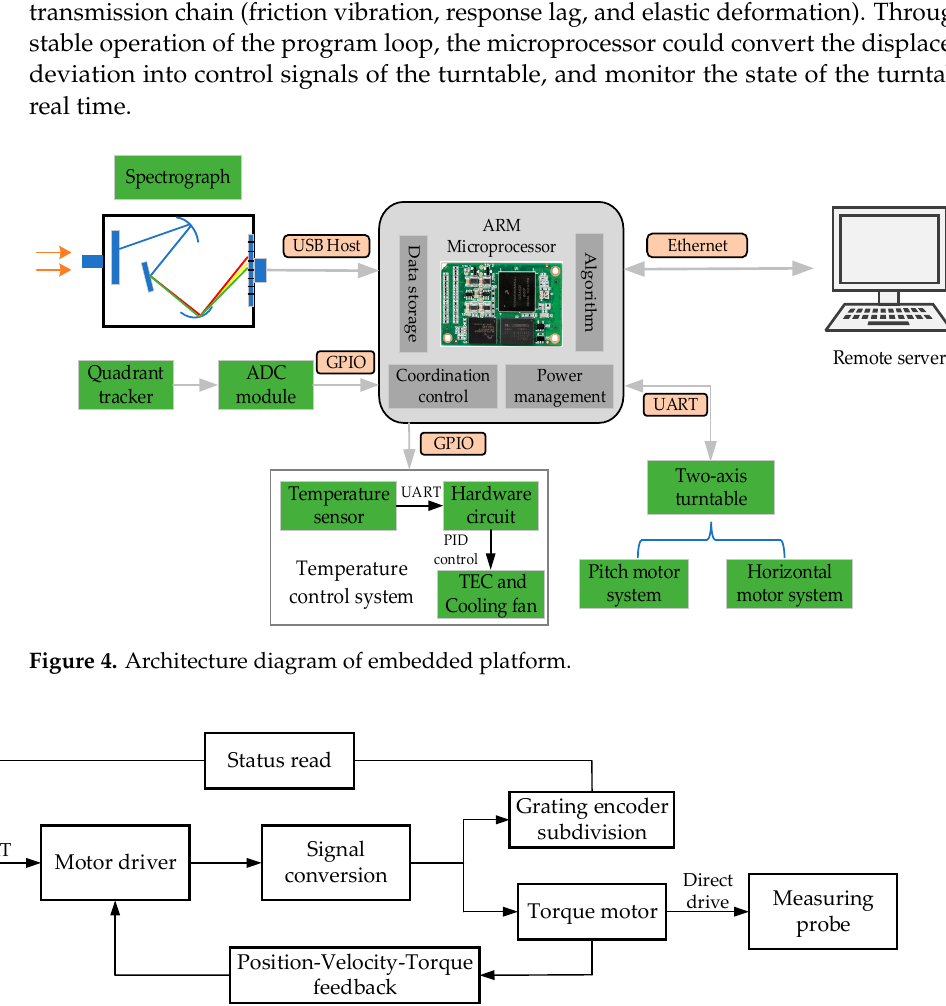
Figure 5. Schematic illustration of turntable control.